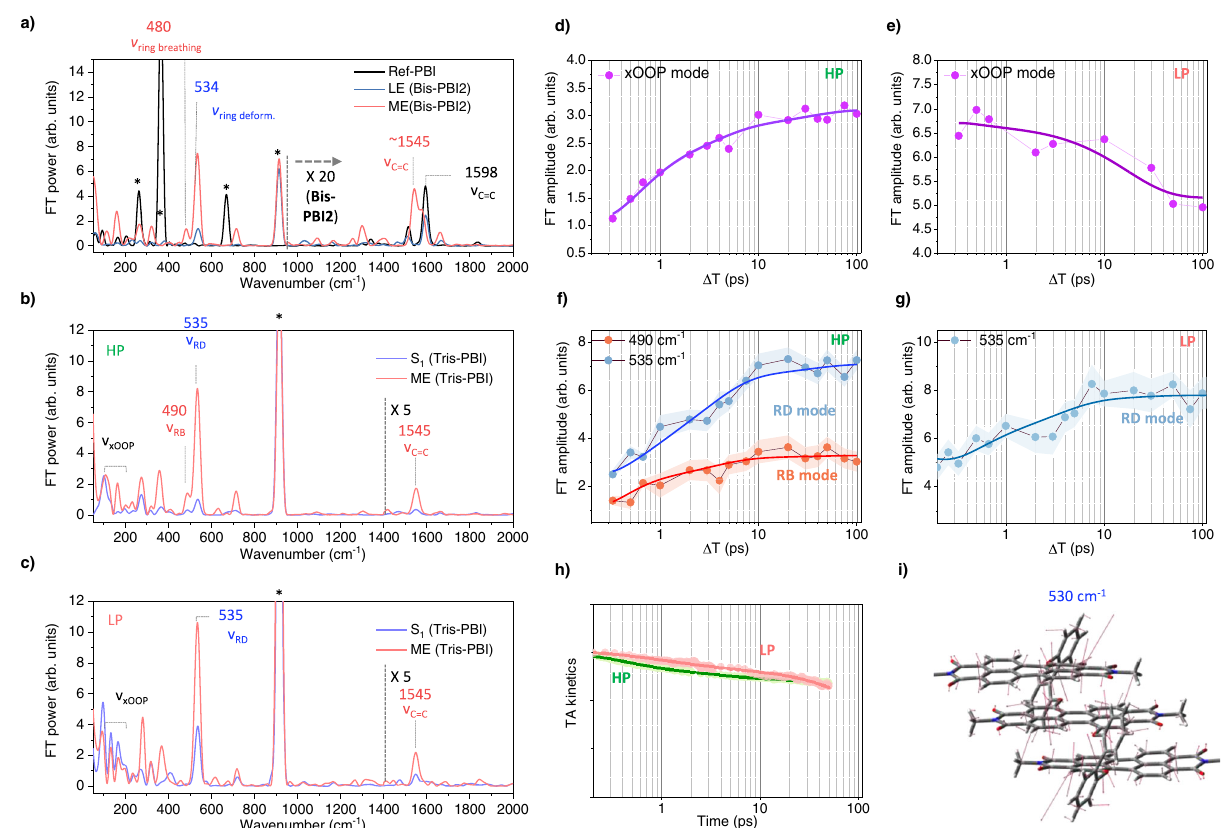
Fig. 5 | Excited-state vibrational spectra of Tris-PBI in THF by the HP (550nm, higherenergy pump) and LP(600nm,lower energypump). a The excited state Raman spectra of Ref-PBI and Bis-PBI2 in CHCl 3 and THF, respectively, corre- spondingtothemonomer-counterunit(blackline),Frenkelexciton(paleblueline), ME(yellowline)states(ThedetailsaredescribedintheSupplementaryNote4).The keyvibrationalmodesaremarked.TherelativeFTpowerof Bis-PBI2 isrescaledfor clarity. The raw excited-state Raman spectra of Bis-PBI2 are shown in Supple- mentary Fig. 33. b , c The excited-state Raman spectra of Tris-PBI for the initial S 1 ( Δ T=300fs) and ME ( Δ T=30ps) states in THF by the HP ( b ) and LP ( c ). The FT power of peaks above 1400cm − 1 is multiplied by 5 to make the high-frequency